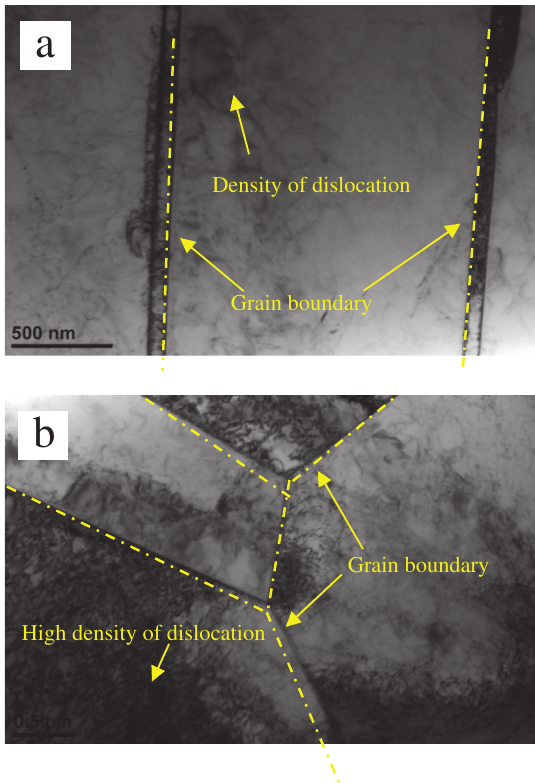
Figure 10: TEM images of impact sample. (a) Untreated material; (b) Impact sample after